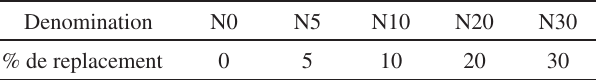
Table 3. Replacement percentage and denomination, of the samples.